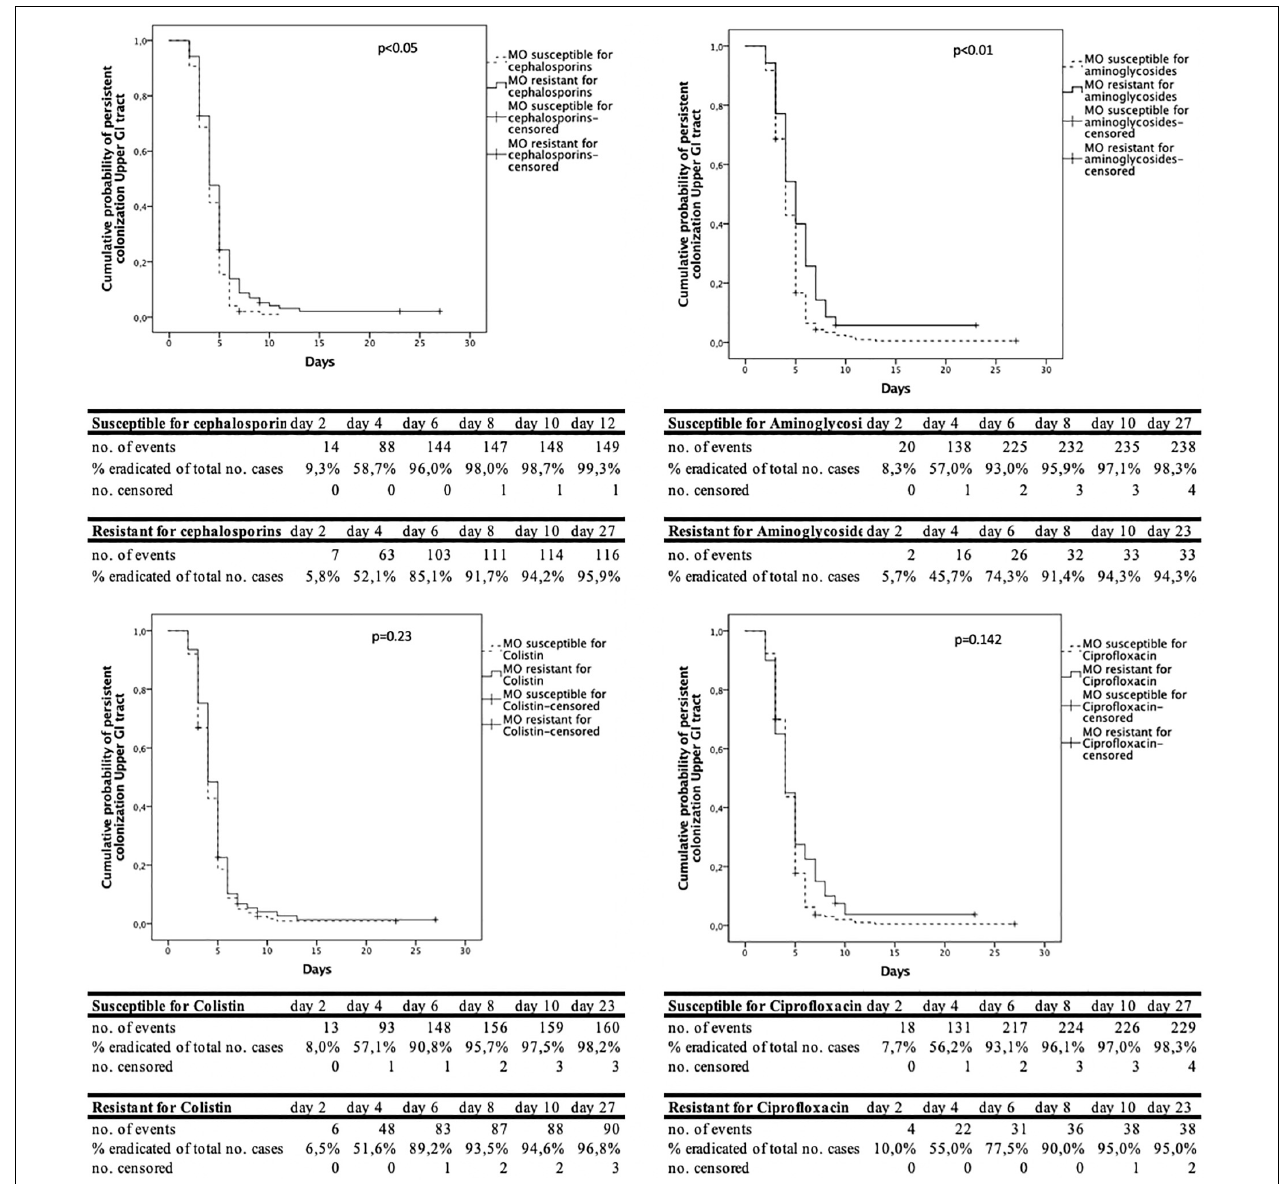
FIGURE 2 | Cumulative decontamination over time for susceptible and resistant microorganisms for the upper gastrointestinal (GI) tract.